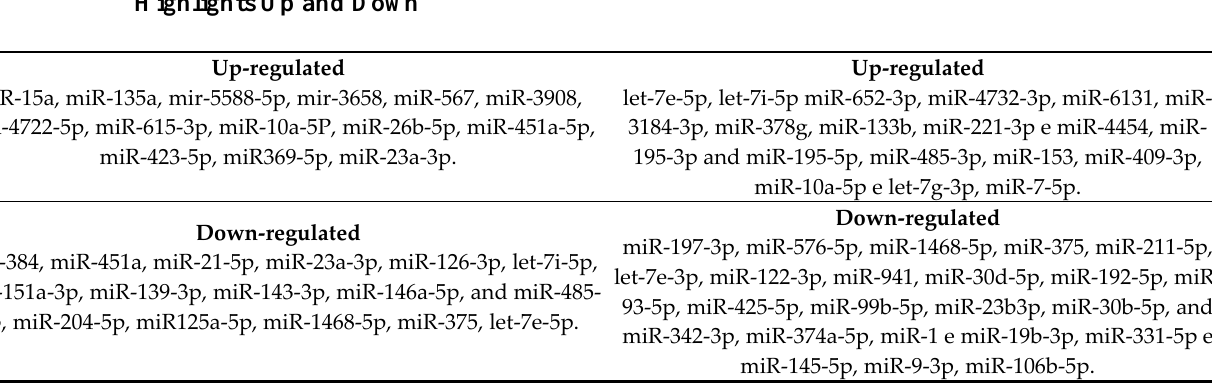
Figure 3. miRNAs above the mean concerning sample identification accuracy. Alzheimer’s disease (AD); Parkinson’s disease (PD). Of the total number of miRNAs identified in the present study, 90 AD and 54 PD, it was statistically analyzed by nominal logistic regression to determine which of these miR- NAs had the highest odds (Odds Ratio) of being identified by qPCR. The results showed five (5) miRNAs — miR-26b-5p (up-regulated), miR-615-3p (up-regulated), miR-4722-5p (up-regulated), miR23a-3p (up-regulated), and miR-27b-3p — for AD, with OR = 2.55 (1023-3432) and p = 0.004 < 0.05. Regarding PD, the results showed miR-374a-5p (down- regulated), with OR = 2.16 (0.087-3.567) and p = 0.0035 < 0.05, as shown in Table 9. Table 9. Results of nominal logistic regression analysis to identify which miRNAs have the highest odds (Odds Ratio) of being identified by qPCR, with p < 0.05 and statistical significance at CI 95%. Alzheimer’ Disease (AD); Parkinson’ Disease (PD). Odds Ratio (OR)/ AD/PD miRNAs Odds Ratio AD/PD